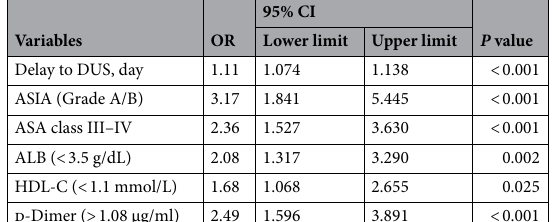
Table 3. Multivariate analysis of factors associated with DVT following spinal fracture.